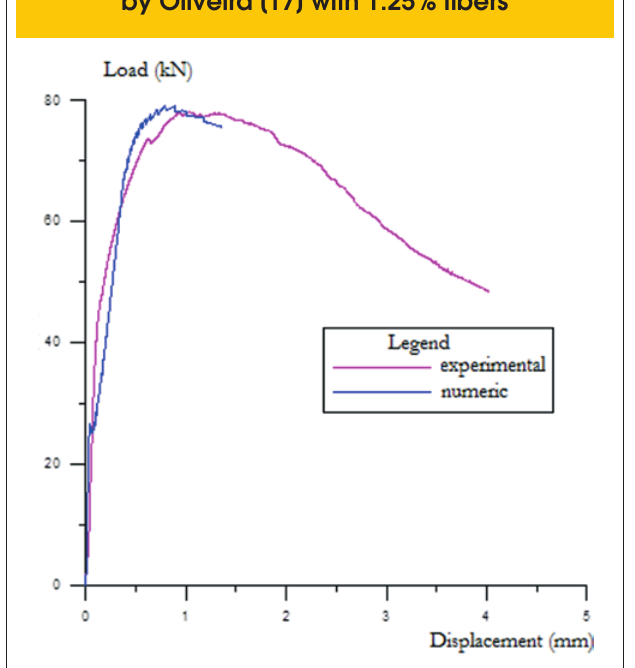
Figure 16 – Numerical curve versus experimental prismatic specimens of V9 beam by Oliveira [17] with 1.25% fibers